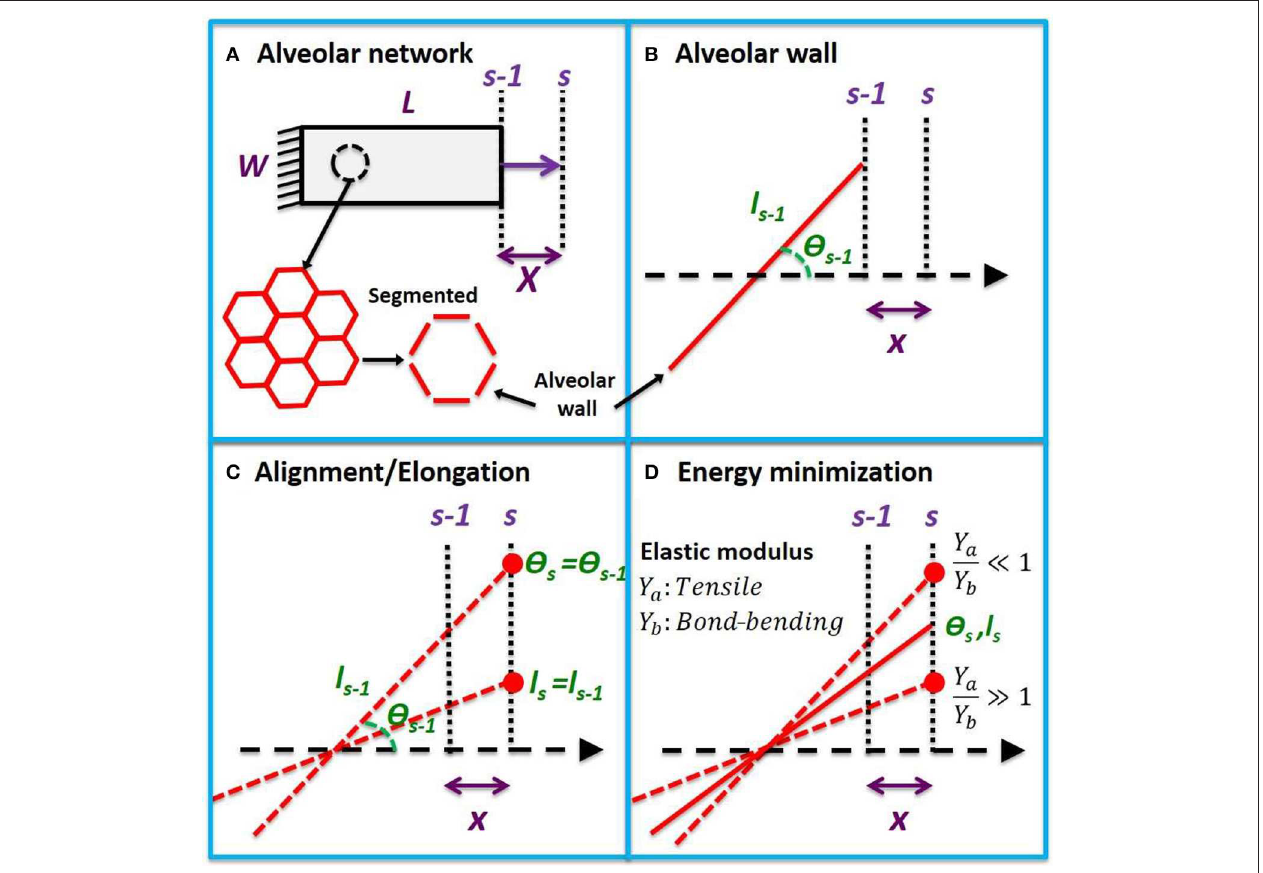
FIGURE 1 | Uniaxial model development. (A) Uniaxial stretching of a tissue strip from step s − 1 to s with an incremental macroscopic displacement X . The tissue is composed of a hexagonal network which can be partitioned into alveolar wall segments. (B) A single wall segment with length l s − 1 and angle θ s − 1 with respect to the direction of stretch at step s − 1. A microscopic displacement x will cause the wall to align by rotation and stretch. (C) The alveolar wall will follow the microscopic displacement between two extremes of pure elongation and pure rotation. (D) When the tensile modulus of the wall is much larger than its bond-bending modulus ( Y a > Y b ), it will rotate, and when its bond-bending modulus is much larger ( Y b >> Y a ), it will elongate in order to minimize energy. The new angle ( θ s ) and length ( l s ) at step s will lie between these two extremes at a location that minimizes the total elastic